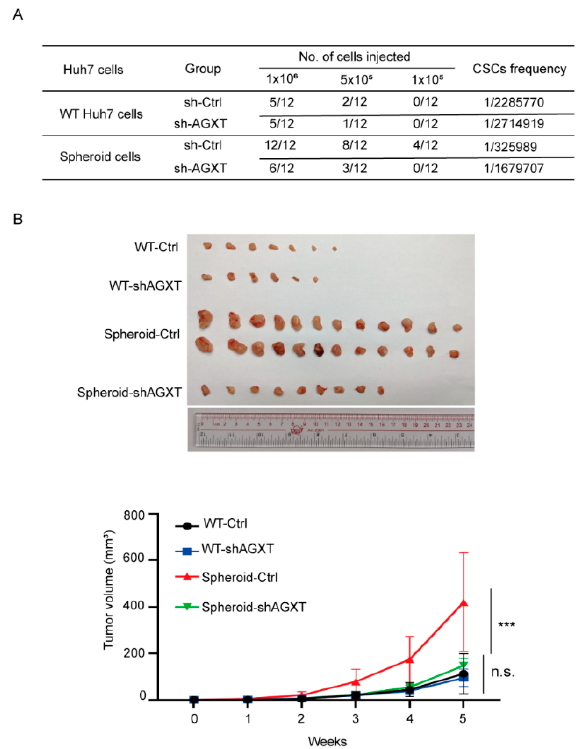
Figure 5. Knockdown of alanine − glyoxylate aminotransferase (AGXT) reduces the oncogenic ability of liver cancer stem cells (CSCs) in mice: ( A ) Adherent and spheroid Huh7 cells with or without AGXT knockdown were subcutaneously injected (10 6 , 5 × 10 5 , and 10 5 cells per mouse) into 5-week-old male NOD/SCID mice. Tumor formation ability and CSC frequency were analyzed; ( B ) the tumor volume of orthotopic xenograft models at 5 weeks (up panel). Tumor growth curve of adherent and spheroid Huh7 cells with or without AGXT (down panel). *** p < 0.001; n.s, nonsignificant.